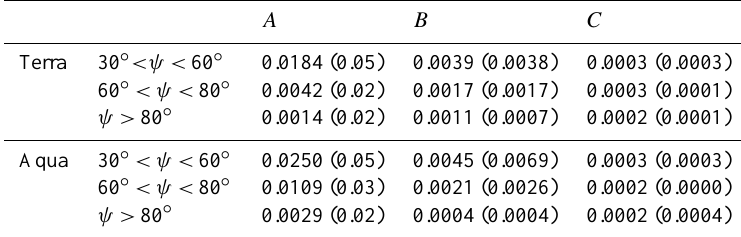
Table 1. Coefficients from Eq. (5) for Terra and Aqua for different ranges of Glint Angle ( ψ ) in Eq. (5) AOD new =AOD old + A − B × u − C × F cld for the MODIS C5 data. The coefficients for the MODIS C4 data are in parenthesis.